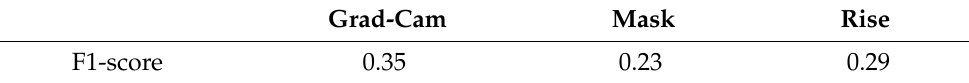
Table 3. F1-score results of different interpretation algorithms. (The larger value is the best).